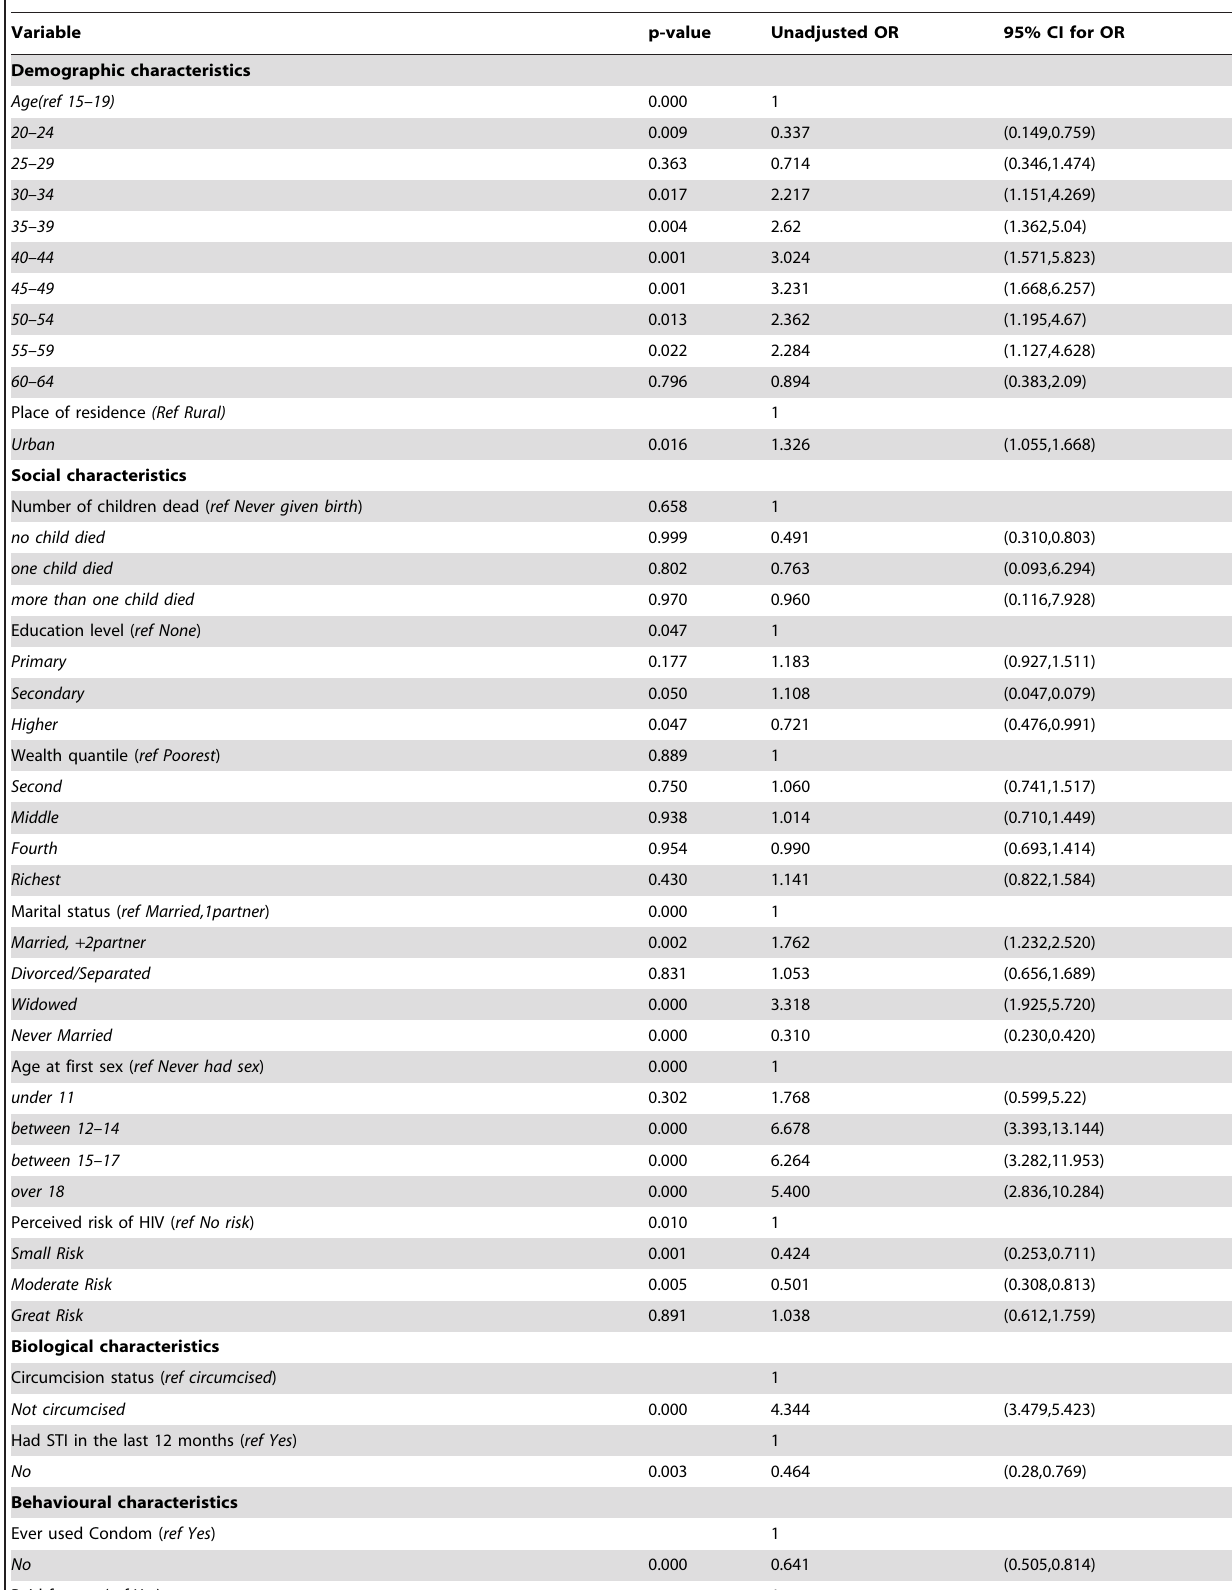
Table 1. Exploratory data